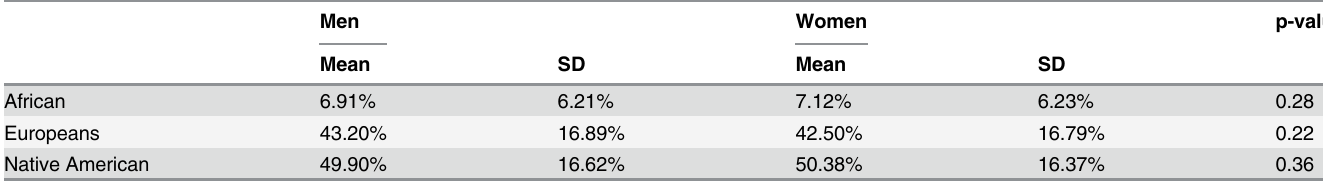
Table 2. Genetic ancestry by gender. Men